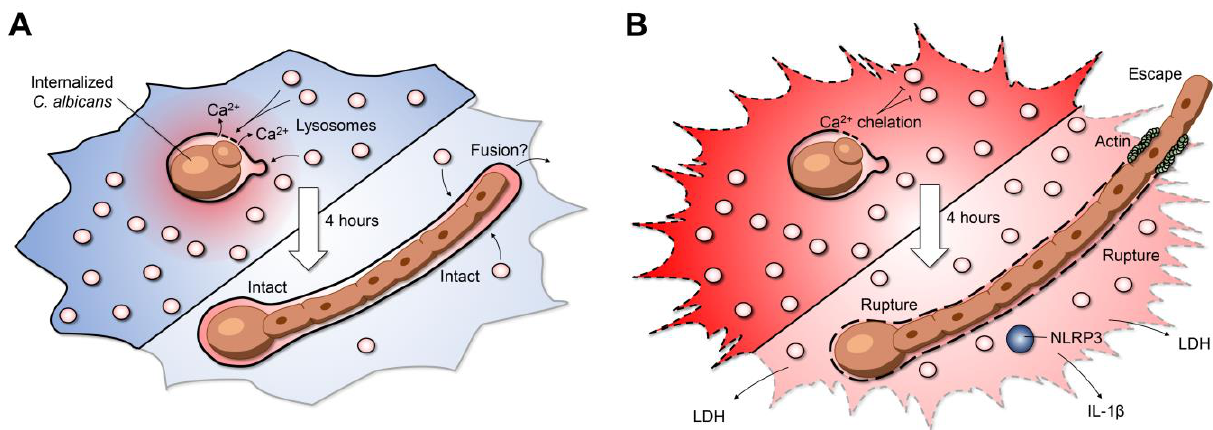
FIGURE 1: Lysosome fusion maintains phagosome integrity during fungal infection. (A) Phagosomes expand their surface area by insertion of lysosomes. As C. albicans initiates filamentation inside the mature phagosome, luminal Ca 2+ is released, leading to recruitment and inser- tion of lysosomes. This preserves phagosome integrity while restricting fungal growth. (B) The second wave of lysosome insertion can be inhibited by applying the Ca 2+ chelator BAPTA. Preventing cytosolic Ca 2+ transients during intraphagosomal growth leads to early phagosome rupture, NLRP3 inflammasome activation, and subsequent macrophage cell death. Actin polymerizes at the site where the hypha protrudes through the plasma membrane, possibly re-sealing the macrophage membrane and preventing leakage of cytosolic